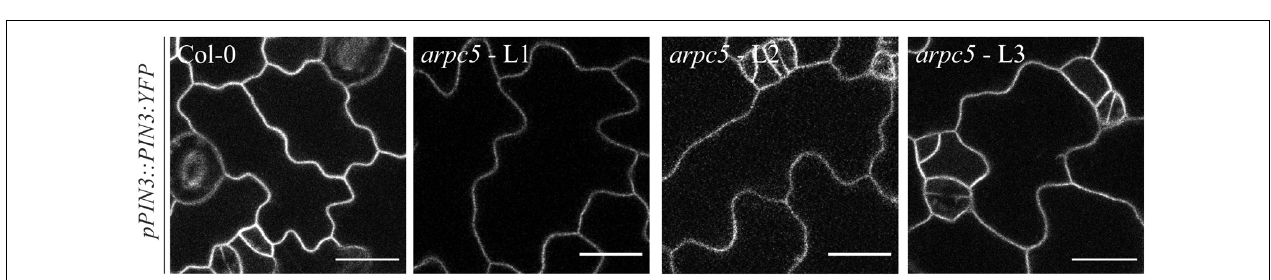
FIGURE 5 | In vivo observation of pPIN3::PIN3:YFP in three-day-old arpc5 plants. L1, L2 and L3 correspond to three independent crosses between pPIN3::PIN3:YFP and arpc5 lines used in this study (scale bar = 20 µ m).